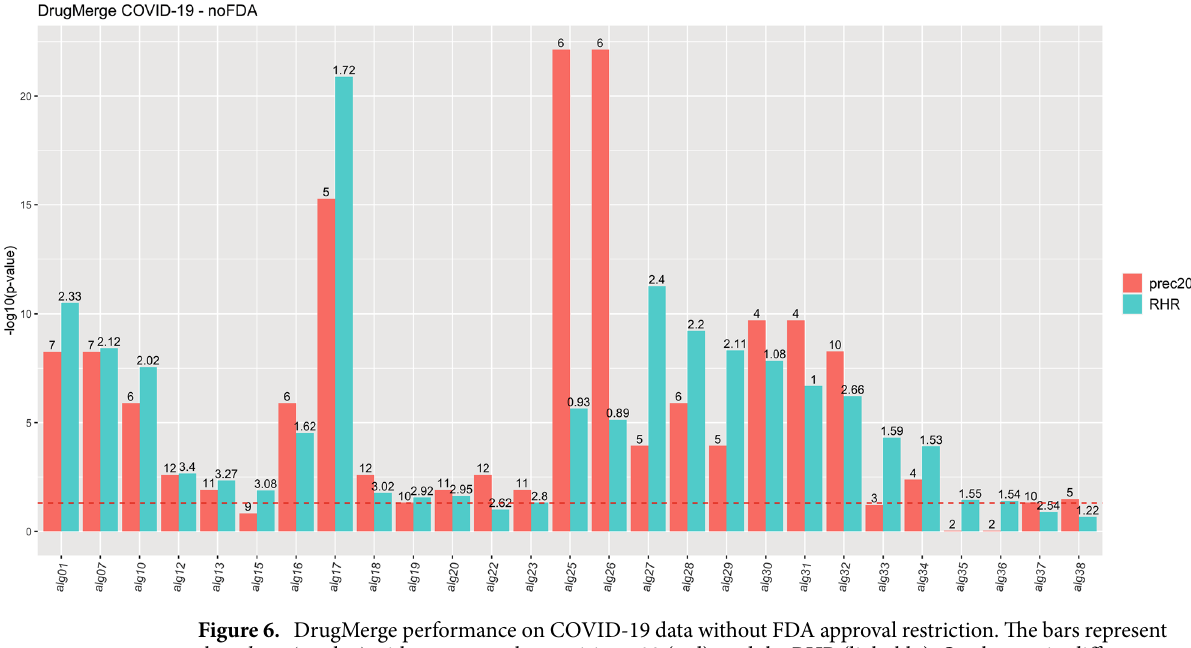
Figure 6. DrugMerge performance on COVID-19 data without FDA approval restriction. The bars represent the − log 10 ( p value ) with respect to the precision@20 (red), and the RHR (light blu). On the x-axis, different algorithms or combinations of them are indexed with aliases, since the complete algorithm names are too long. The mapping between them is on Table S9. The numbers on the top of the bars show the absolute values of precision@20 or RHR. The dotted red line represents the limit of significance ( − log 10 ( 0.05 ) ). All the bars above the dotted line show a significant p-value. The plot has been generated by the ggplot2 81 R